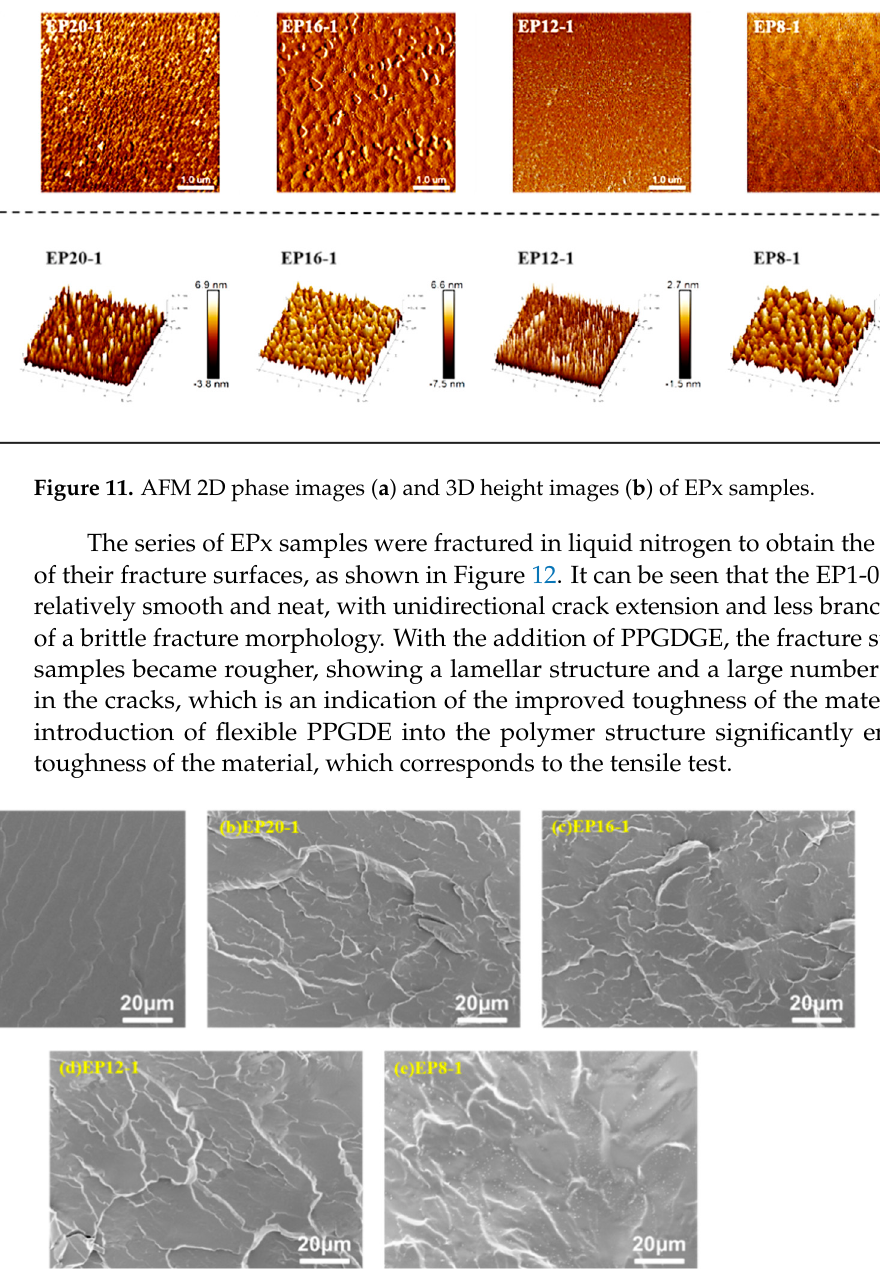
Figure 12. SEM images of the brittle fractured surfaces of EPx samples fractured in liquid nitrogen. ( a ) EP1-0, ( b ) EP20-1, ( c ) EP16-1, ( d ) EP12-1, ( e ) EP8-1.